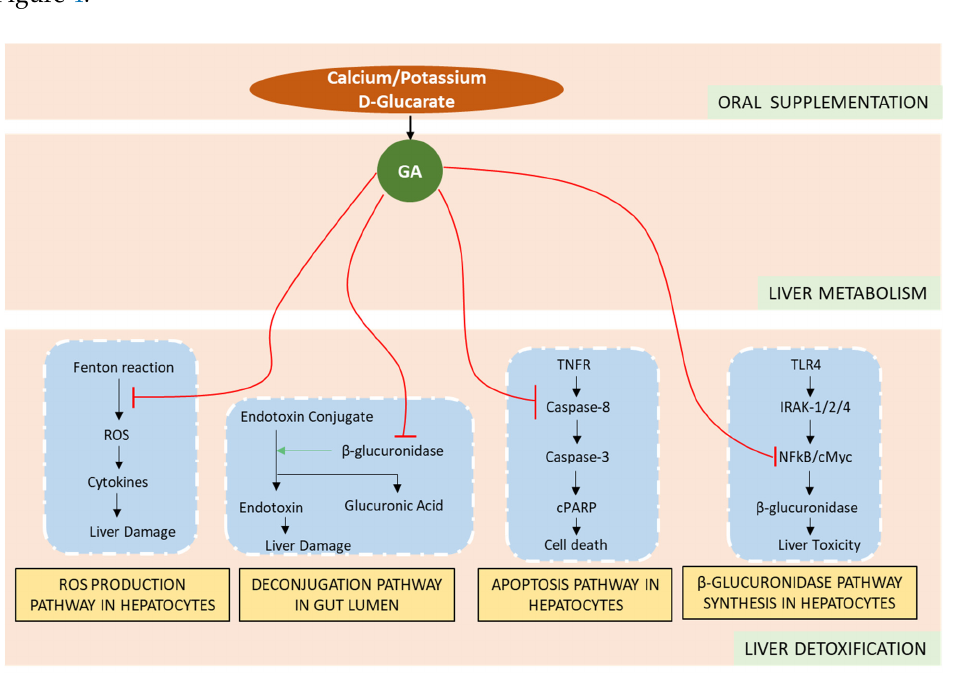
Figure 4. Molecular interactions of glucarate salt active metabolites, GA, on the four mechanisms of liver detoxification.